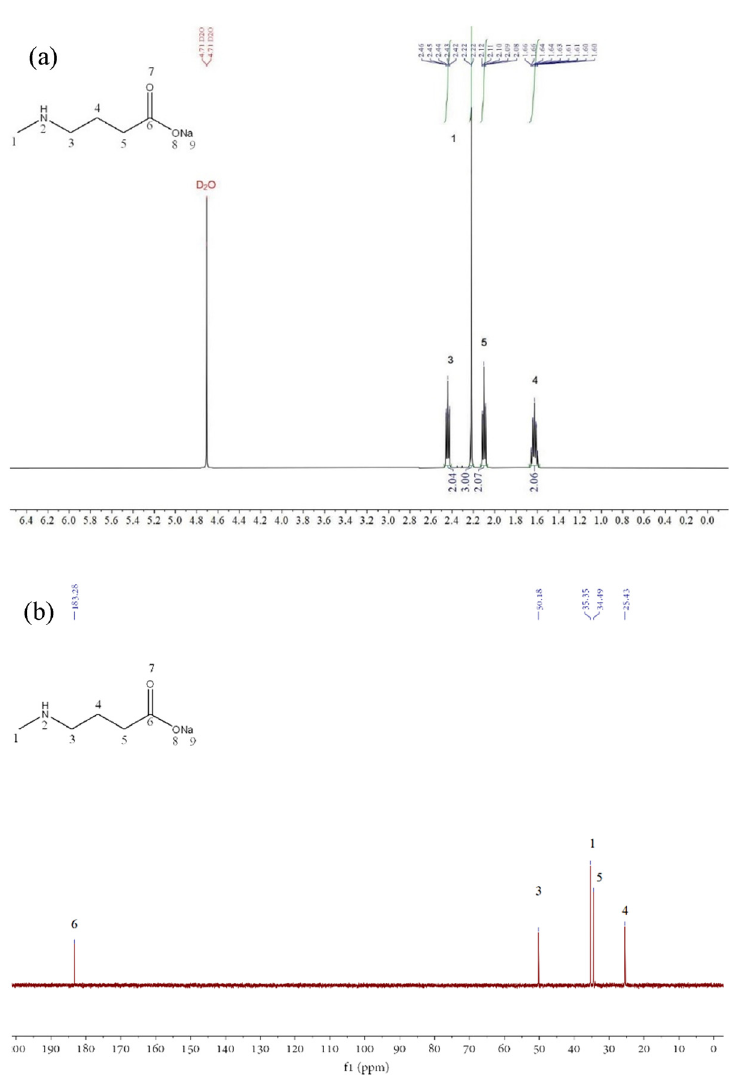
Figure A1: ( a ) 1 H - NMR of SMAB, ( b ) 13 C - NMR of SMAB, ( c ) 1 H - NMR of p - SCMAB, ( d ) 13 C - NMR of p - SCMAB, ( e ) 1 H - NMR of m - SCMAB, ( f ) 13 C - NMR of m - SCMAB, ( g ) 1 H - NMR of 4,4 ′ - dichlorodiphenyl ether, and ( h ) 13 C - NMR of 4,4 ′ - dichlorodiphenyl